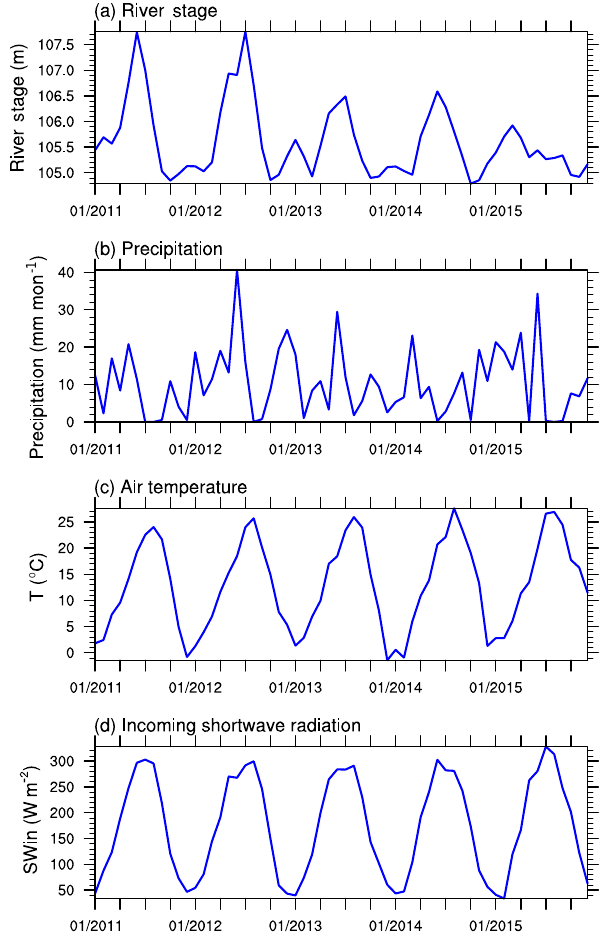
Figure 6. Hydrometeorological drivers in the study period: (a) monthly mean river stage, (b) monthly total precipitation, (c) monthly mean surface air temperature, and (d) monthly mean incoming shortwave